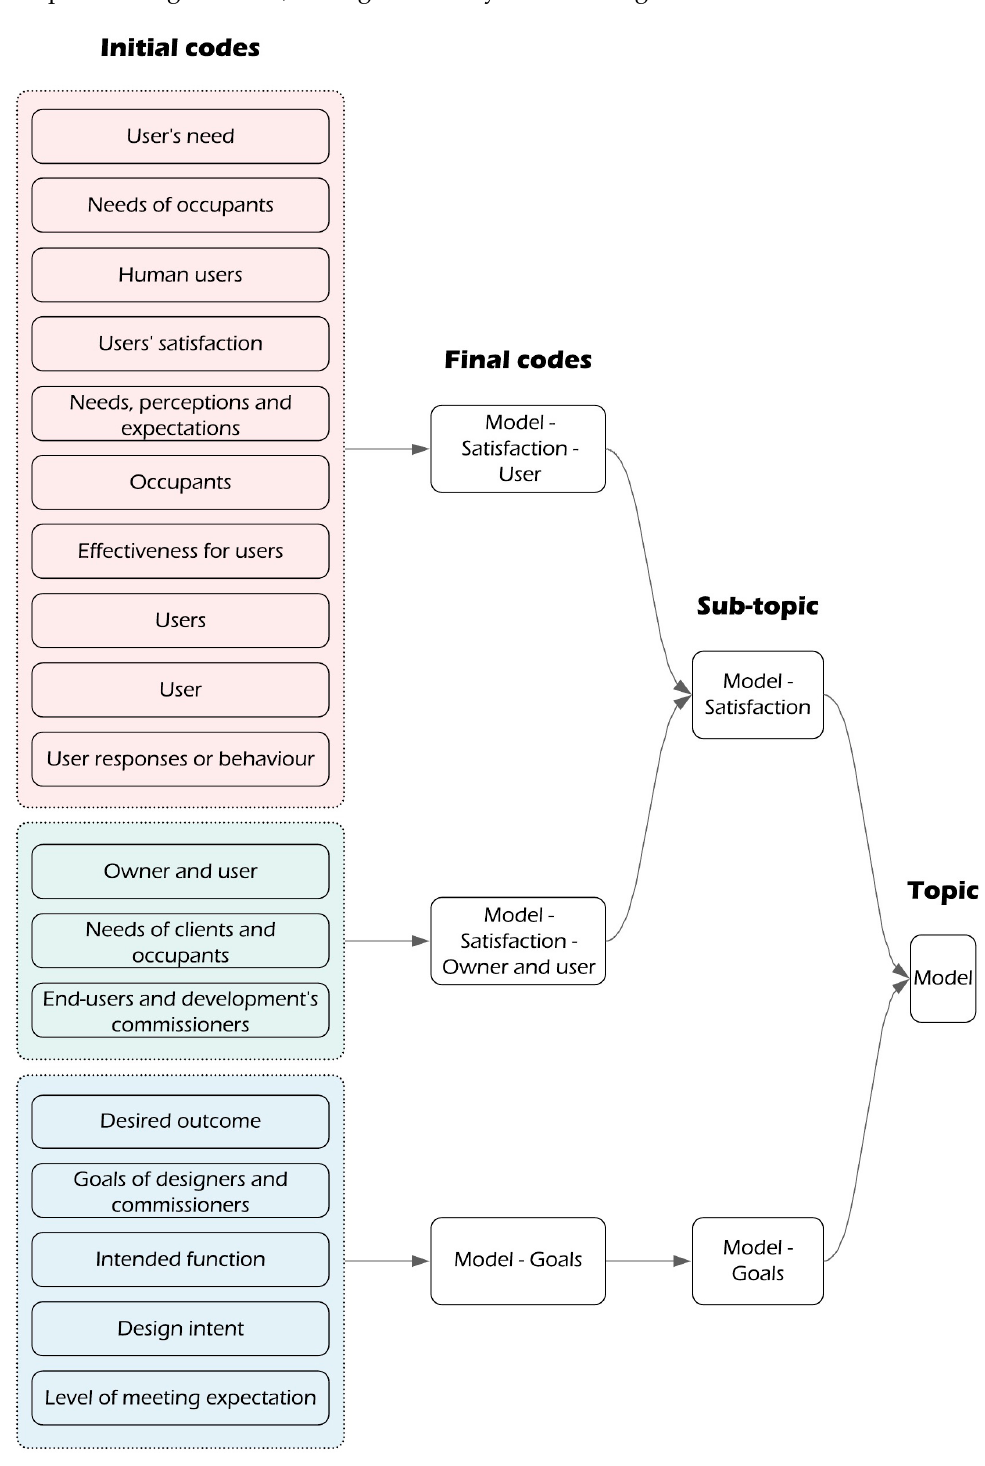
Figure 3. An example of the axial coding process demonstrating how open codes were grouped, edited, and structured into the final codes in this study.